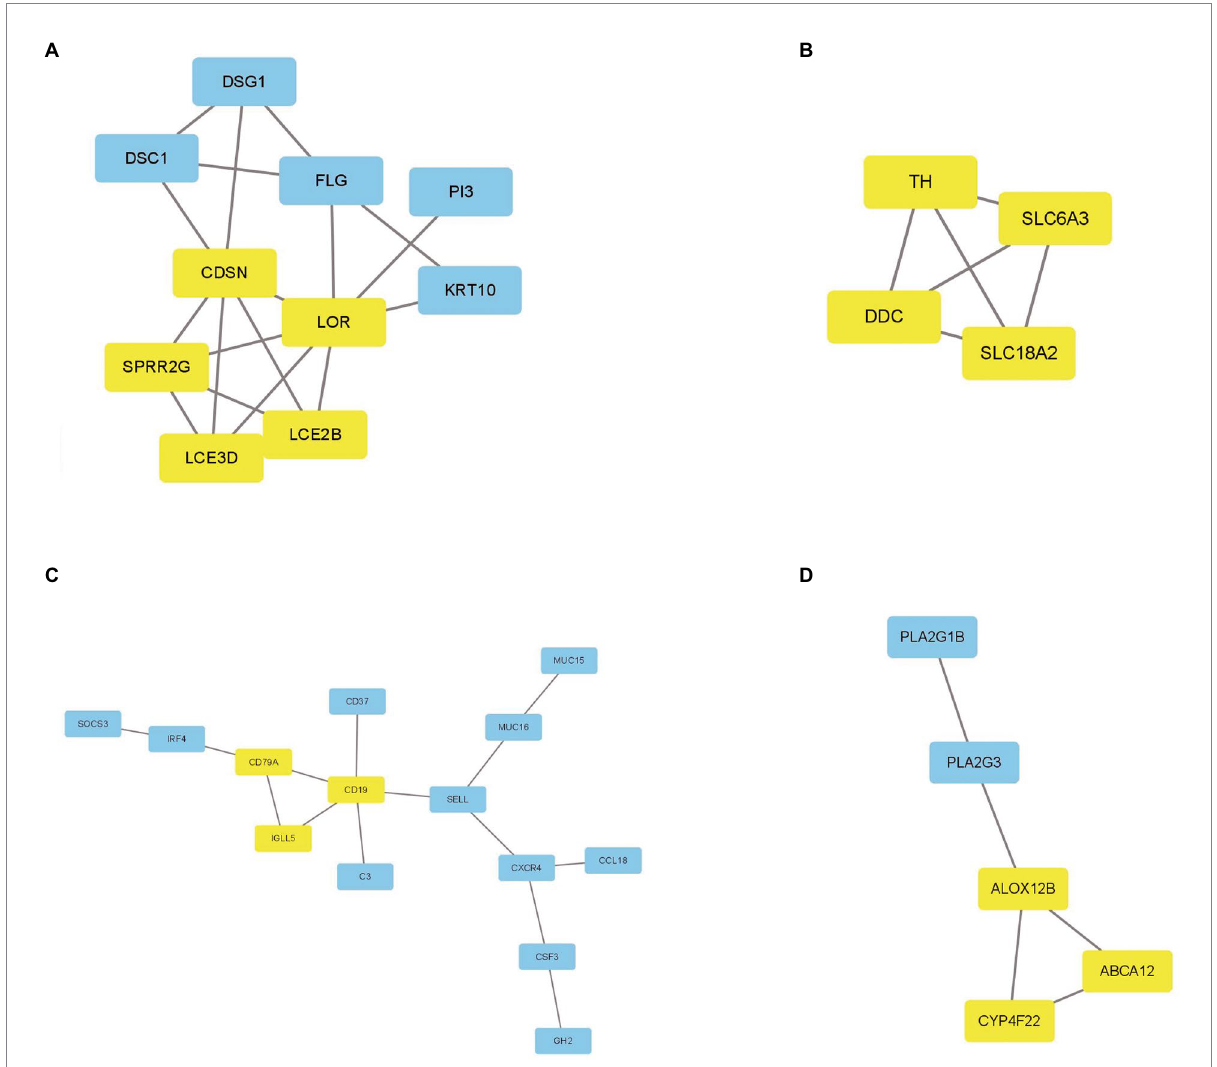
FIGURE 5 The key PPI network modules in GSE23586 and GSE7621 dataset. (A–D) Four key PPI network modules were performed by